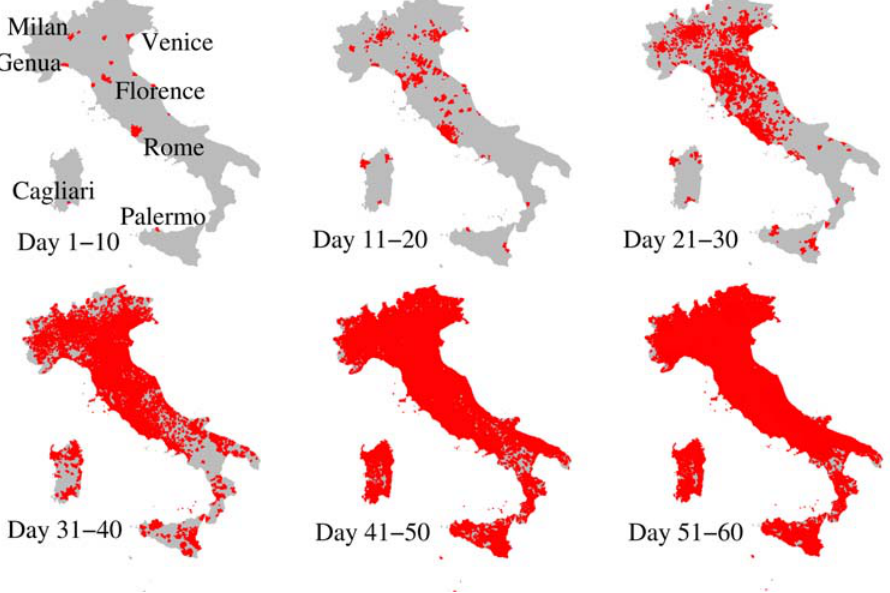
Figure 2. Spatial spread of pandemic influenza in Italy, R 0 =1.7. Red areas represent municipalities where at least one case is present.